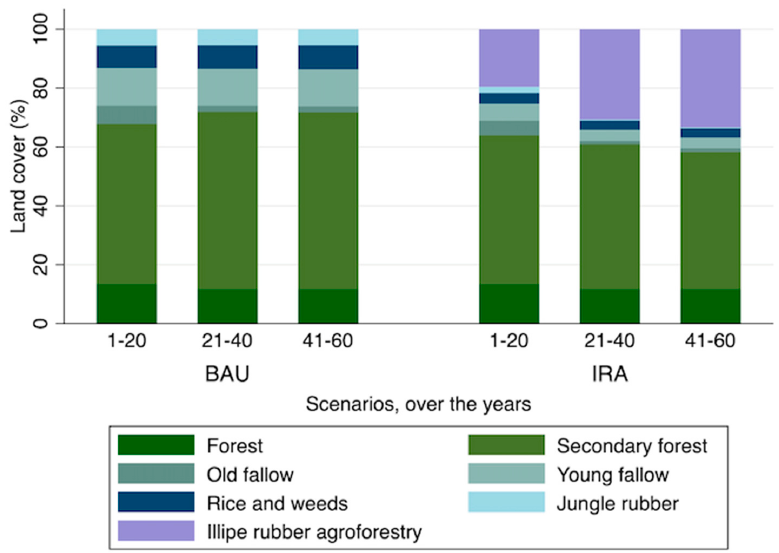
Figure 9. Simulation results: land cover trends over time.